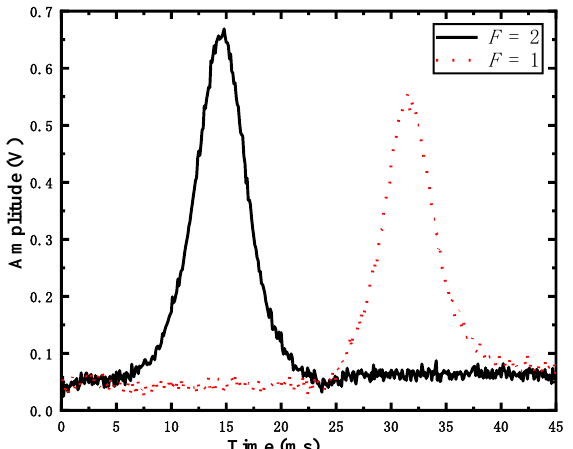
Figure 4. The results of the demodulated dispersive signal and its slope versus temperature of the Rb cell. ( a ): The measurements of the demodulated dispersive signal with varying temperatures T ∈ [34 °C, 59 °C]. ( b ): The blue points represent the slope of the demodulated dispersive signal fringe of the 87 Rb D2 F = 1 → F ′ = 1.